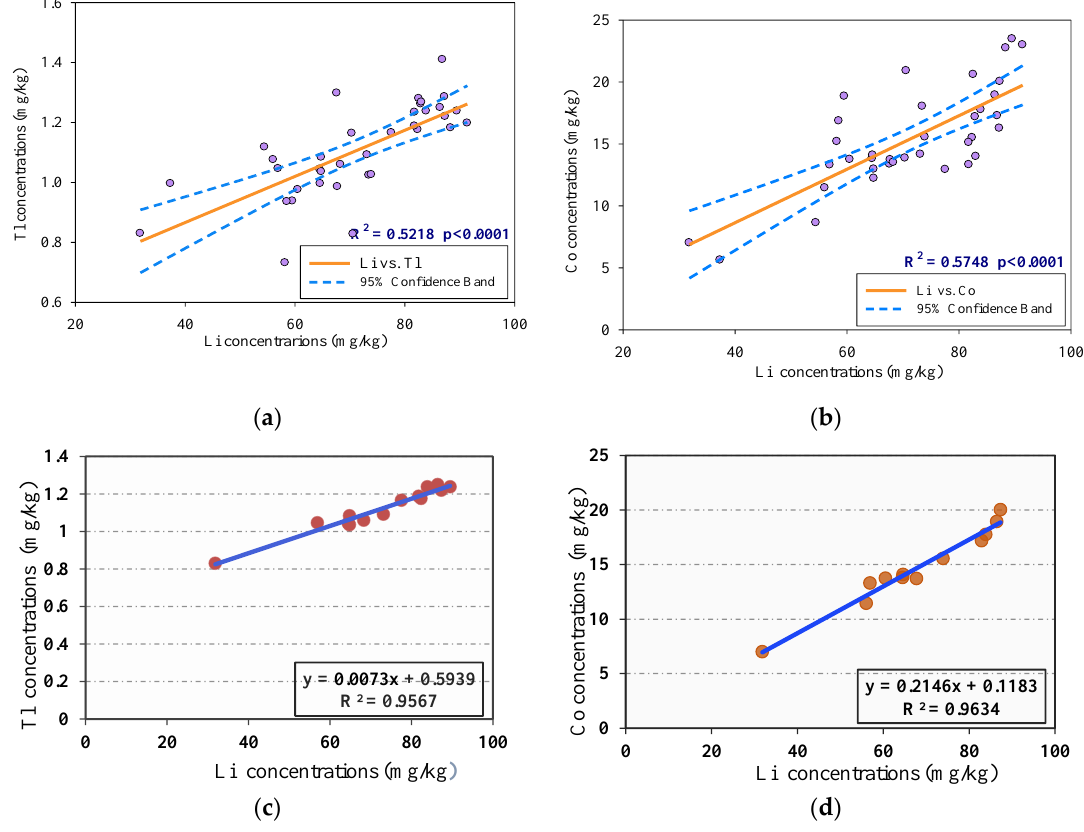
Figure 3. Normalization analysis and geochemical baselines for Tl and Co. ( a ) The linear regression analysis between Tl and Li; ( b ) The linear regression analysis between Co and Li; ( c ) The geochemical baseline for Tl; ( d ) The geochemical baseline for Co.